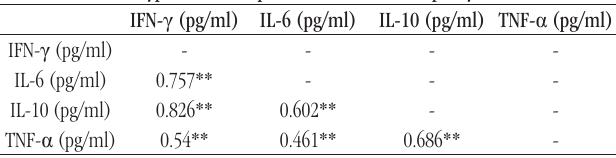
taBLE 2 − Correlation among inflammatory cytokines in type 1 diabetes patients without retinopathy